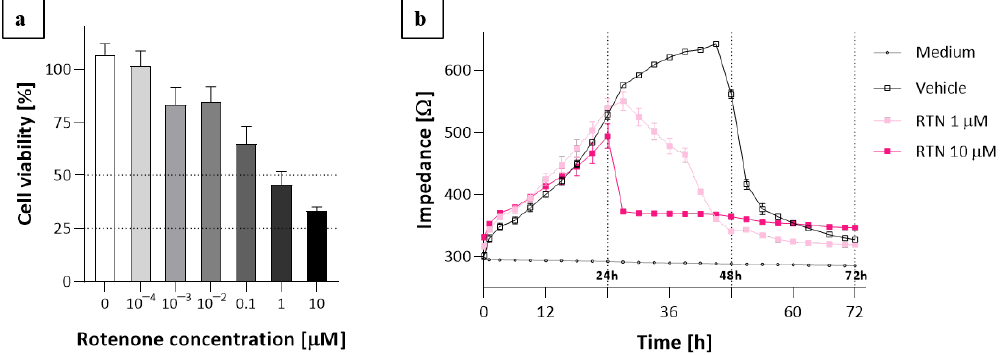
Figure 4. Influence of rotenone on Vero cell line during 48 h treatment assessed by ( a ) MTT assay and monitored by ( b ) ECIS method. Data are presented as mean value ± SEM.